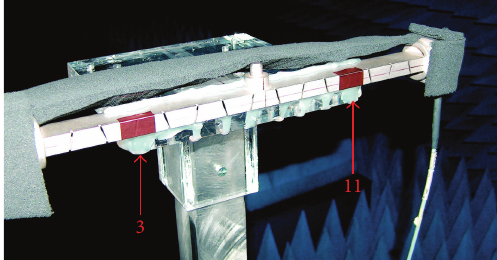
Figure 10: Photograph of slotted waveguide array with failures at positions 𝑛 = 3 and 𝑛 = 11 .